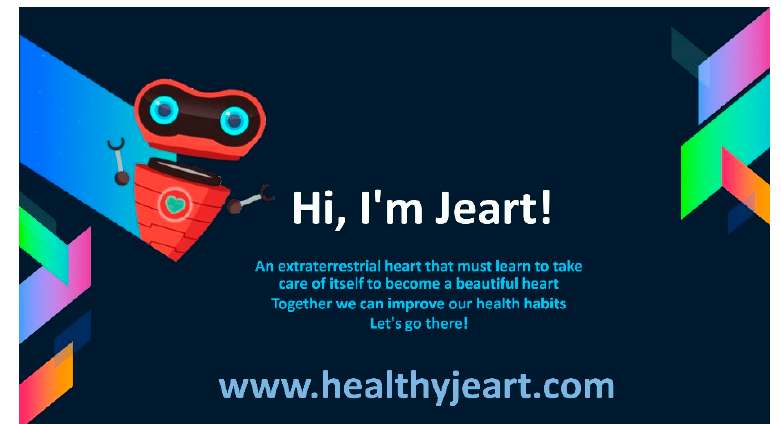
Figure 1. Presentation of Healthy Jeart.